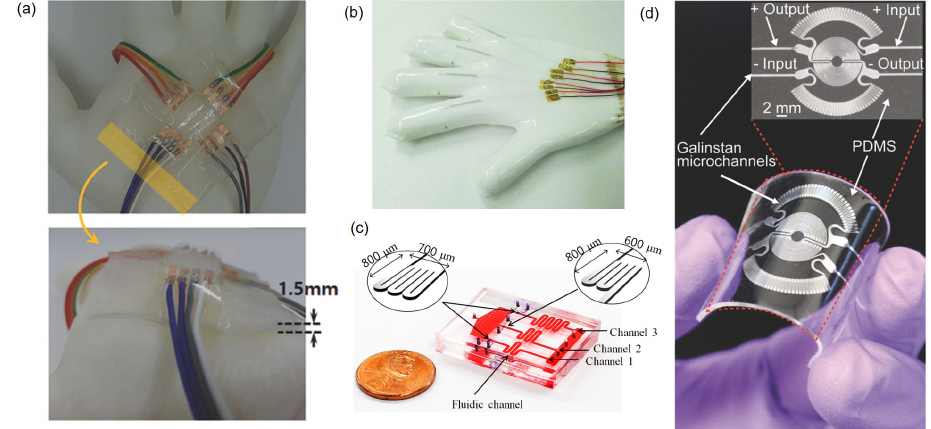
Figure 15. ( a ) Pictures of the 2D tactile sensor exhibiting 4 horizontal and 4 vertical EGaIn lines, thus 16 intersecting points. Reproduced with permission from [10]; published by John Wiley and Sons, 2018. ( b ) Liquid metal patterned glove that captures hand or finger gestures. Reproduced with permission from [51]; published by John Wiley and Sons, 2019. ( c ) Resistive liquid metal pressure sensor which measures the pressure in microfluidic channels. Reproduced with permission from [93]; published by MDPI, 2015. ( d ) Wearable liquid metal pressure sensor that monitors the heart rate to detect the BPM. Reproduced with permission from [94]; published by John Wiley and Sons,